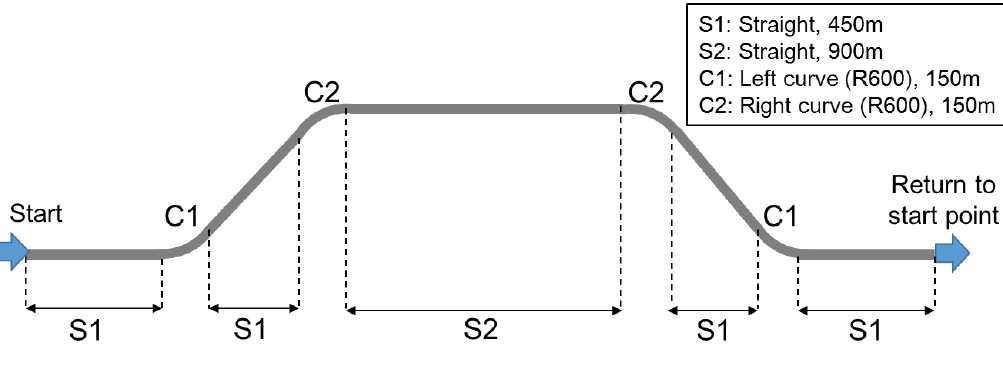
Figure 1. A section of the driving course [20].